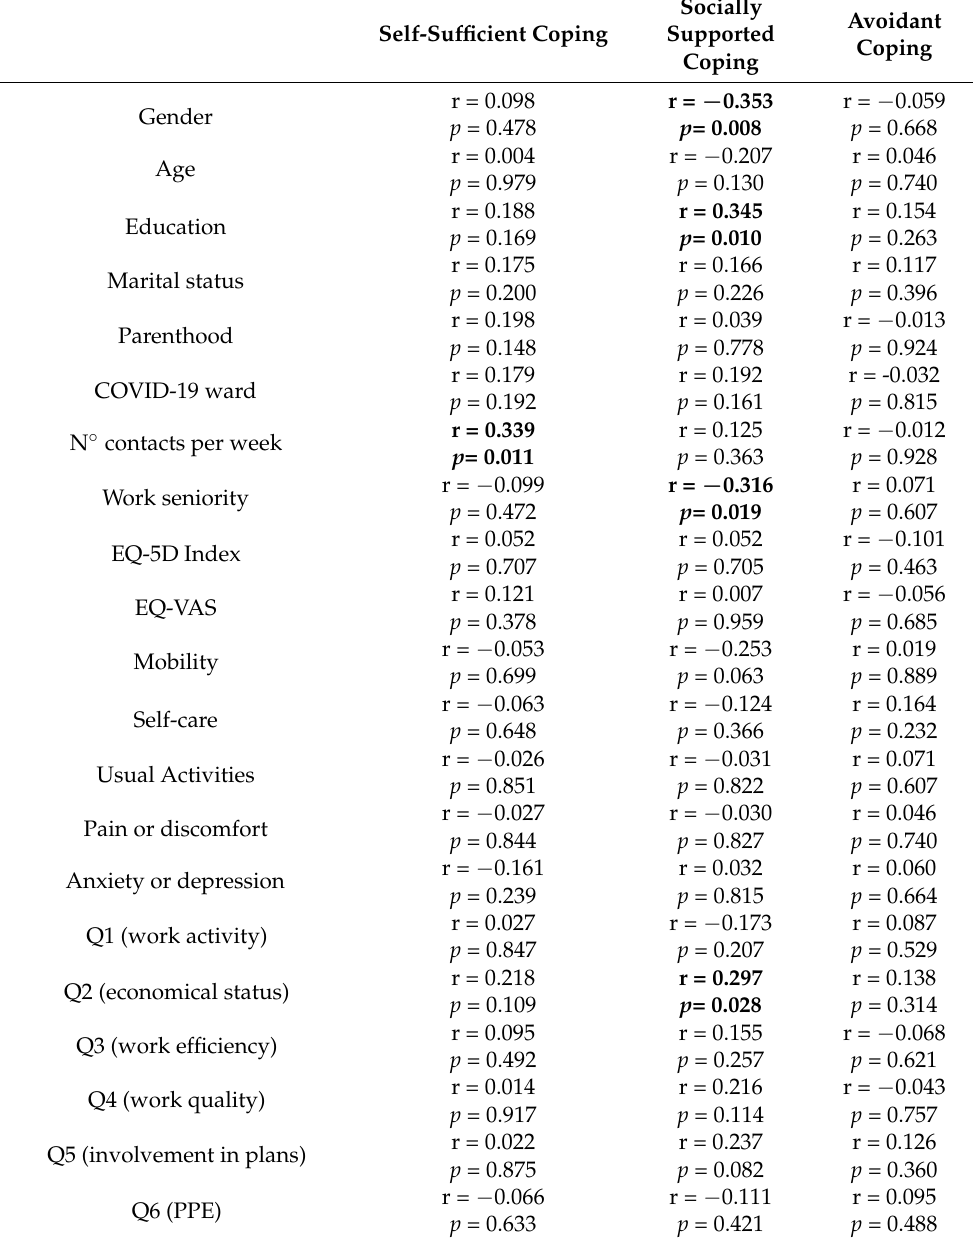
Table 7. Correlation matrix between Brief-COPE and sociodemographic characteristics, work-related factors, European Quality of Life, and work environment perception in group N. Socially Self-Sufficient Coping Supported Coping